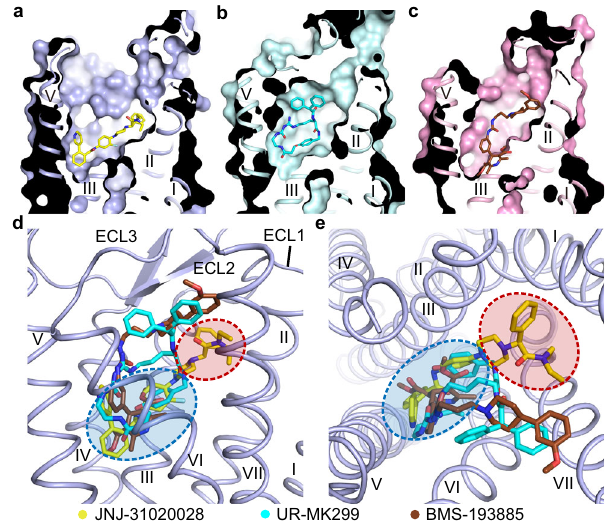
Fig. 4 Comparison of ligand-binding modes between Y 2 R and Y 1 R. a – c Cutaway view of ligand-binding pockets in Y 2 R and Y 1 R. The structures of Y 2 R – JNJ-31020028 ( a ), Y 1 R – UR-MK299 ( b ) (PDB code: 5ZBQ), and Y 1 R – BMS-193885 ( c ) (PDB code: 5ZBH) are shown in cartoon and surface representations, with the receptors colored light blue, light cyan, and pink, respectively. The ligands JNJ-31020028, UR-MK299, and BMS-193885 are shown as yellow, cyan, and brown sticks, respectively. d , e Comparison of ligand-binding sites in Y 2 R and Y 1 R. d Side view. e Extracellular view. Only the receptor in the Y 2 R – JNJ-31020028 structure is shown in cartoon representation for clarity. The red ellipse indicates the extended binding pocket in Y 2 R and the blue ellipse indicates the binding site at the bottom of the ligand-binding cavity shared by Y 1 R and Y 2 (Fig. 4d, e). In contrast, the phenylethyl and diethyl amide moi- eties of JNJ-31020028 in Y 2 R approach the extracellular surface of the receptor, interacting with ECL1 and the extracellular tips of helices II, III, and VII, which form an extended binding pocket of Y 2 R (Fig. 4d, e).